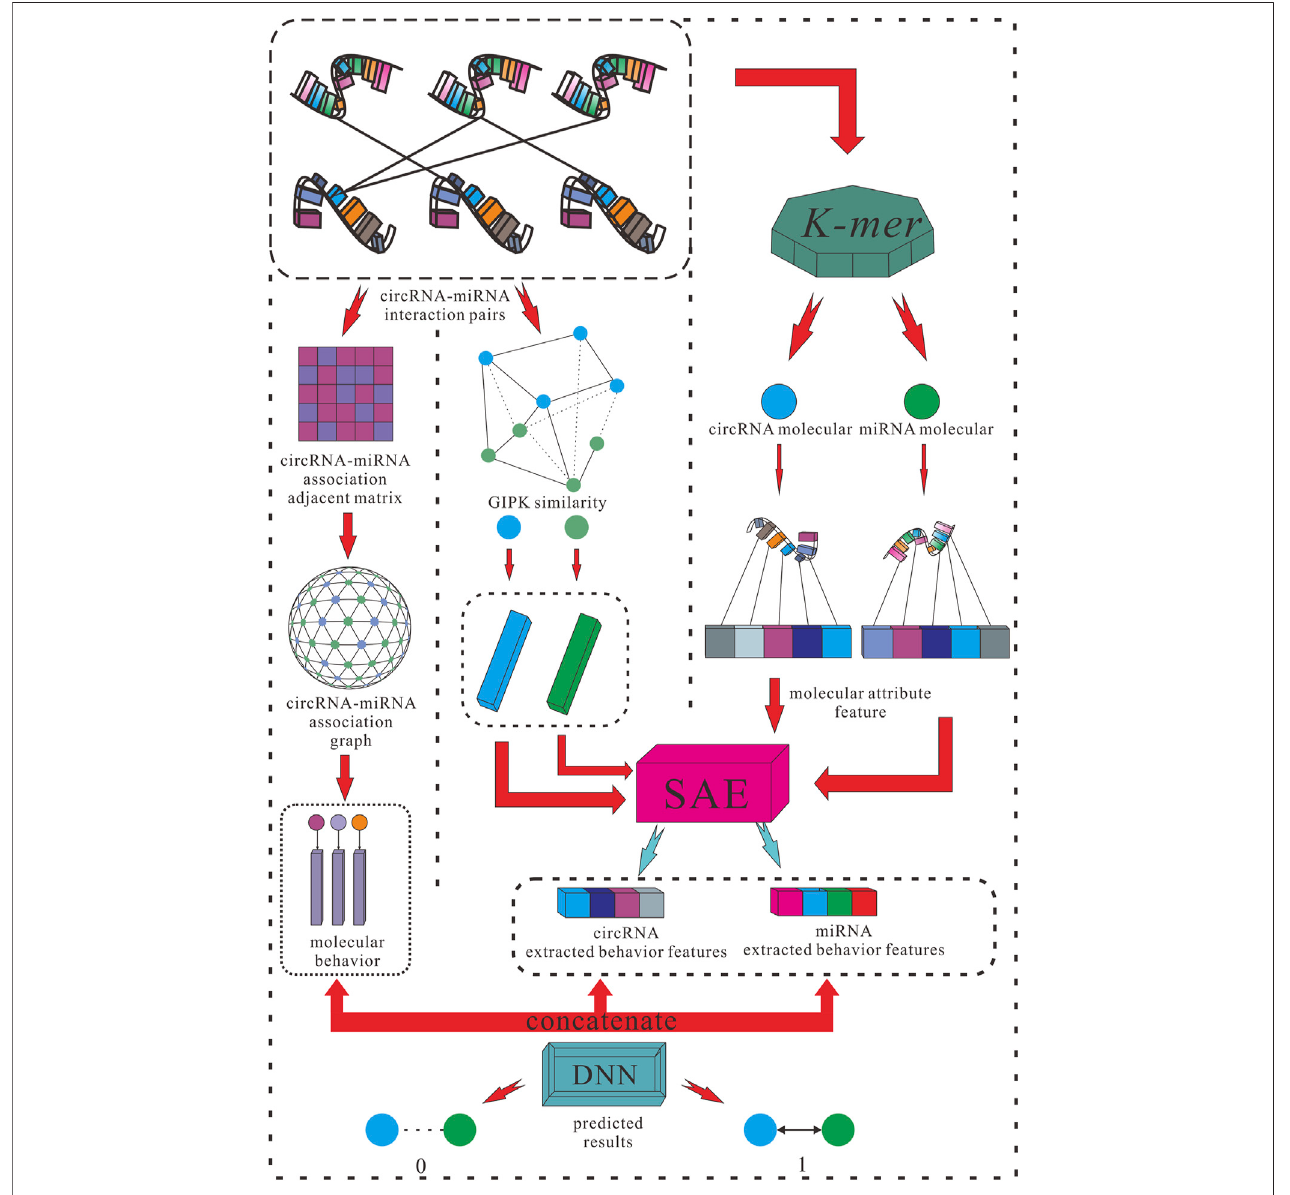
FIGURE 2 | Flowchart of